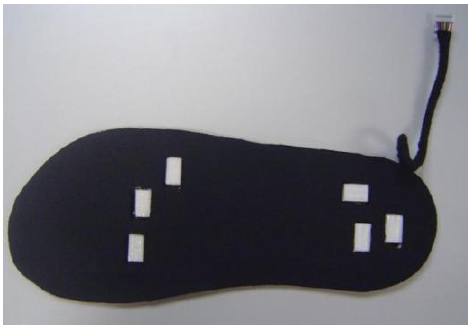
Figure 24. Fabric pressure sensing array indicating sensor placement